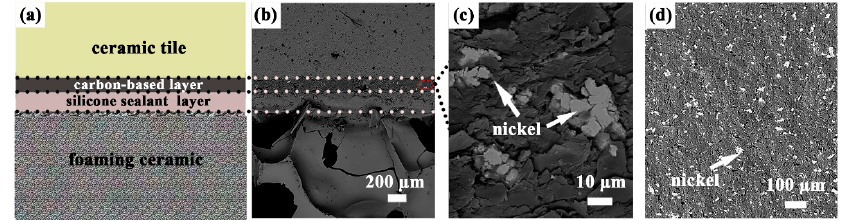
Figure 1. ( a ) Structure illustration of the laminated ceramics; ( b ) cross-section backscattering electron image of the laminated ceramics; ( c ) cross-section backscattering electron image of the carbon-based layer; ( d ) surface backscattering electron image of the carbon-based layer.